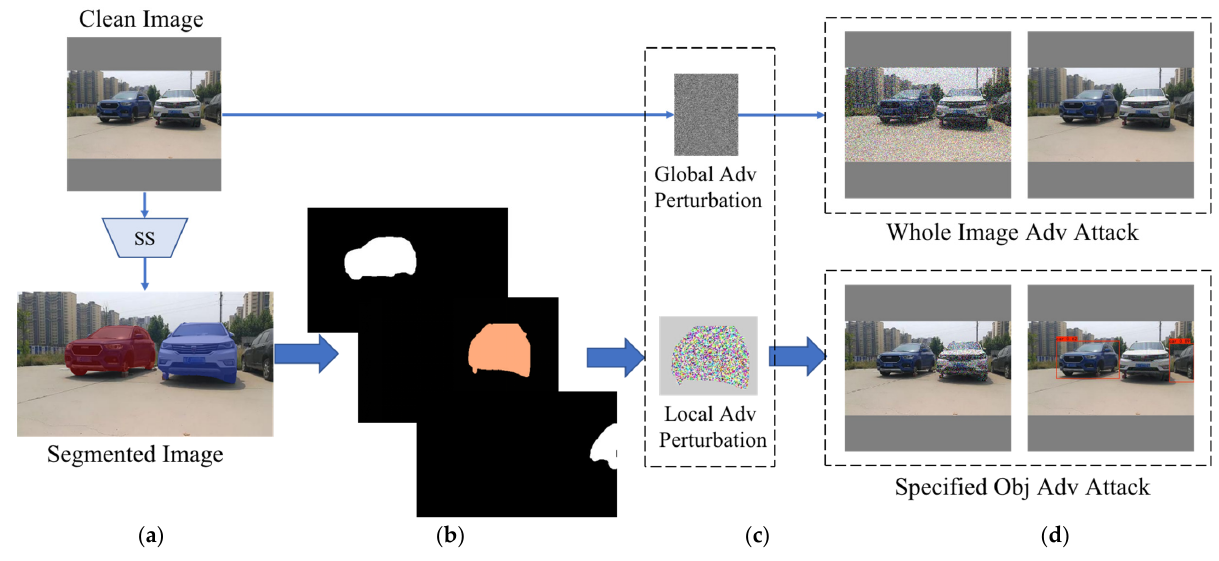
Figure 1. Comparison of different attack method processes. ( a ) Image Segmentation. ( b ) Mask Generation. ( c ) Adversarial Perturbation Generation. ( d ) Adversarial Example Generation. The upper half of the figure shows the traditional adversarial example generation algorithm. The bottom counterpart is the algorithm proposed in this paper.